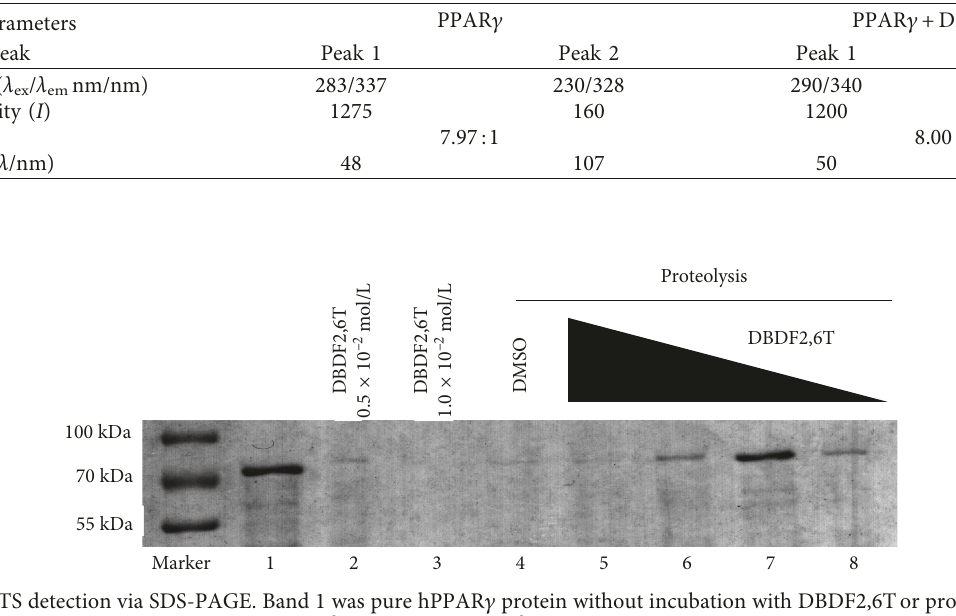
2 mol/L, 0.5 3 mol/L, 8: 0.5 10 10 × × − − →